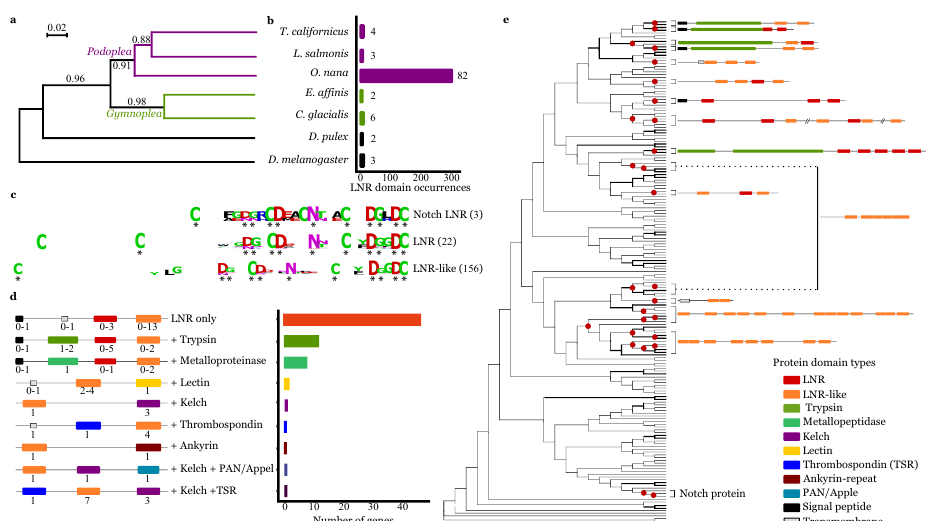
Figure 3. Lin-12 Notch Repeat (LNR) protein domain burst and domain associations in the Oithona nana proteome. ( a ) Phylogeny of five copepod species and two other arthropod species based on 18S ribosomal sequences. The numbers at internal branches show aLRT branch support. The scale bar represents the nucleotide substitution rate. ( b ) LNR domain occurrences in seven Arthropoda proteomes, detected by HMM. The number at the front of each bar corresponds to the number of detected genes. ( c ) Consensus sequences of the O. nana Notch-LNR, LNR, and LNR-like domains generated by WebLogo. The asterisks represent the conserved sites. ( d ) Schemata of the O. nana LNR and LNR-like protein structure. Numbers under each domain represent the possible occurrence range. The barplot represents the occurrence of the nine structures. ( e ) Phylogenetic tree of the O. nana LNR and LNR-like domains. Bold branches have aLRT support ≥ 0.90. The red circles represent tandem